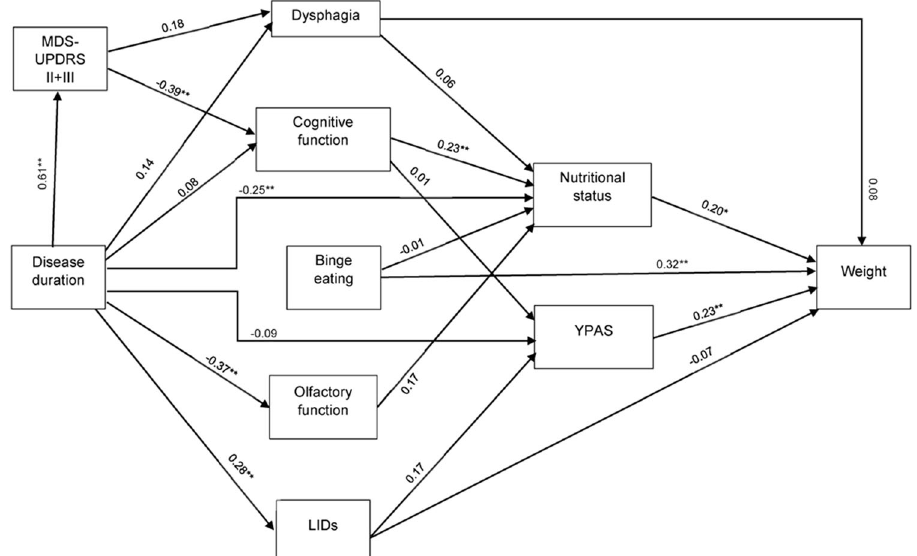
Fig. 1 Flow chart connecting PD-related factors to body weight, as obtained using structural equation modelling. Age-adjusted, gender- adjusted, and height-adjusted standardized regression weights are presented for relevant pairs of variables. p < 0.05, ** p <